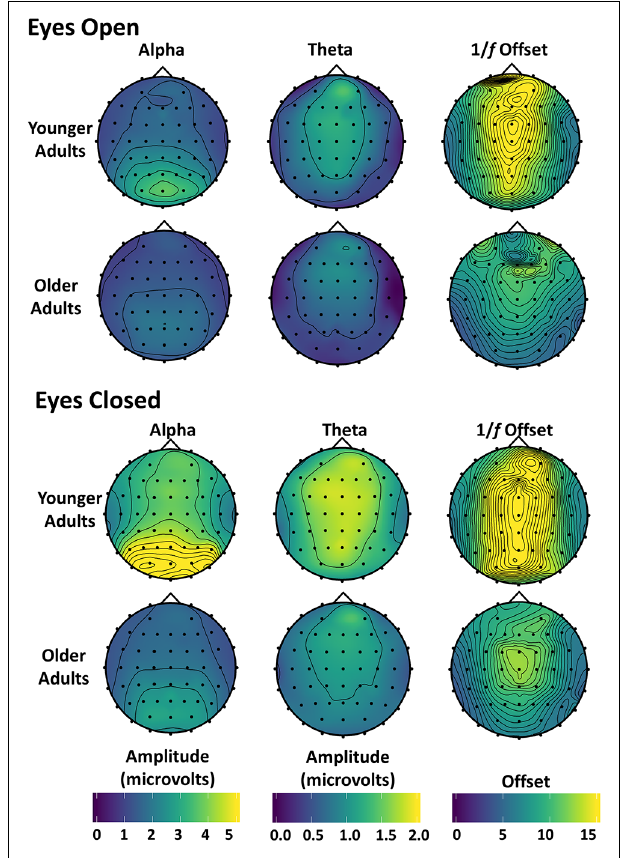
FIGURE 4 | Topographic maps of alpha, theta, and 1/ f offset: alpha and theta amplitude and 1/ f offset with eyes open (top) and closed (bottom) are shown for both younger and older adults. Amplitude was used instead of power because power differences between younger and older adults were too large to be plotted meaningfully using the same scale. The magnitude of the 1/ f offset from the detrending procedure (the magnitude of the β -weight) was plotted at each electrode